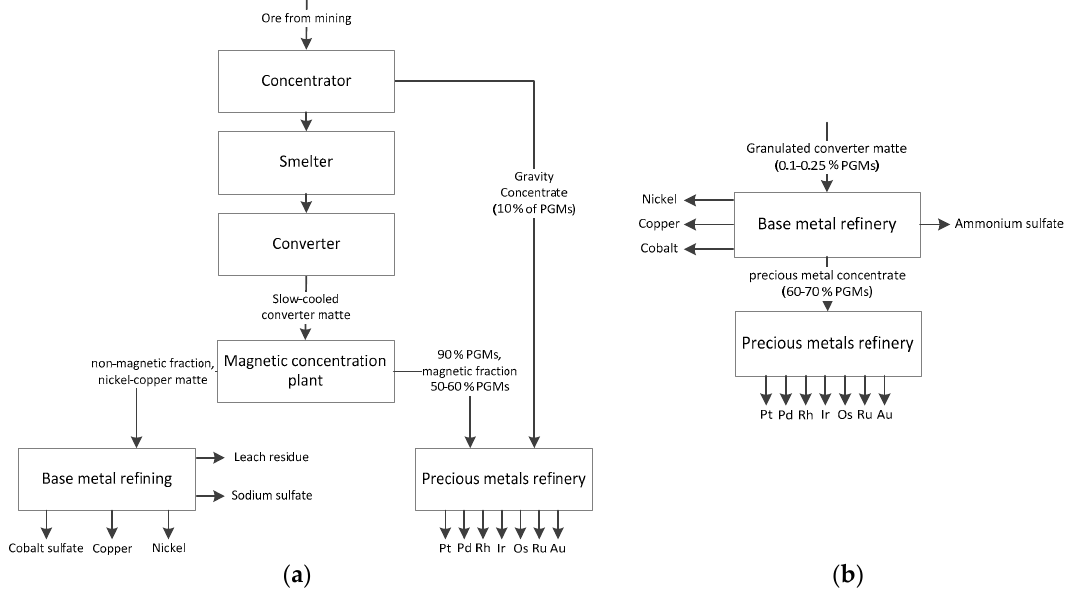
Figure 4. The magnetic concentration process for separating the PGEs from the base metals ( a ); and the refining of PGEs from the smelter matte by the whole matte leaching process ( b ). Adapted from